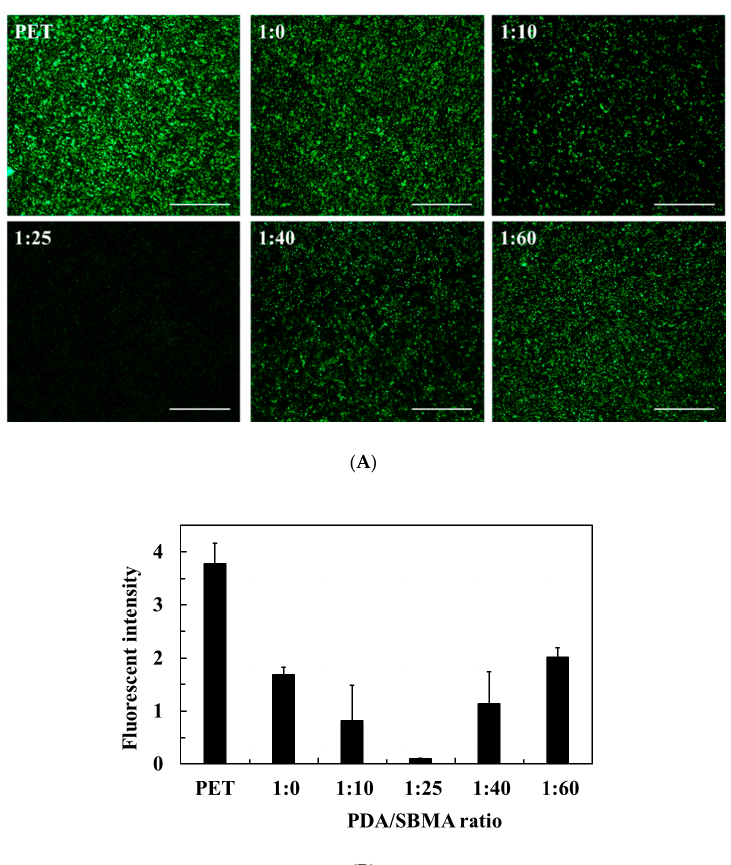
Figure 6. ( A ) Fluorescence images of E. coli attachment on the various PDA / SBMA coatings. Scale bar = 100 µ m. ( B ) The fluorescence intensity was analyzed from the photographs by Image J. n = 5.